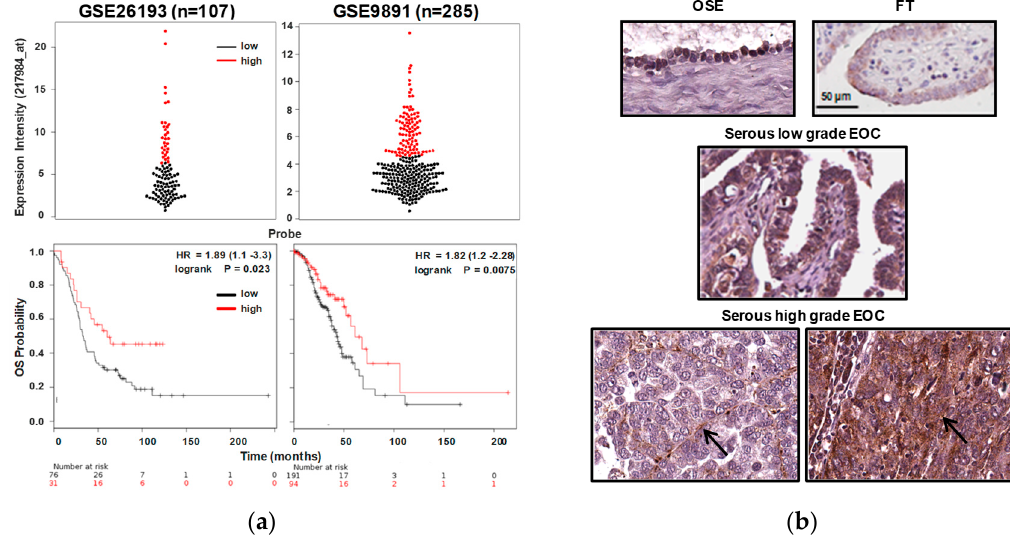
Figure 1. RNASET2 transcript expression in epithelial ovarian cancer (EOC) is associated with better prognosis. ( a ) Correlation of RNASET2 expression and overall survival (OS) was analyzed in GSE26193 (left panel) and GSE9891 (right panel) datasets. RNASET2 expression intensity is reported on the top, the Kaplan–Meyer plots are reported on the bottom. ( b ) Representative images of immunohistochemistry (IHC) with anti-RNASET2 Ab on normal ovarian (OSE) and fallopian tube (FT) epithelia, and on representative serous low grade and high grade EOC samples, as reported in Table 1. Arrows highlight RNASET2 staining at the levels of extracellular matrix (ECM) deposition. Table 1. Immunohistochemical analysis with anti-RNASET2 Ab on formalin-fixed paraffin- embedded EOC tissue sections.